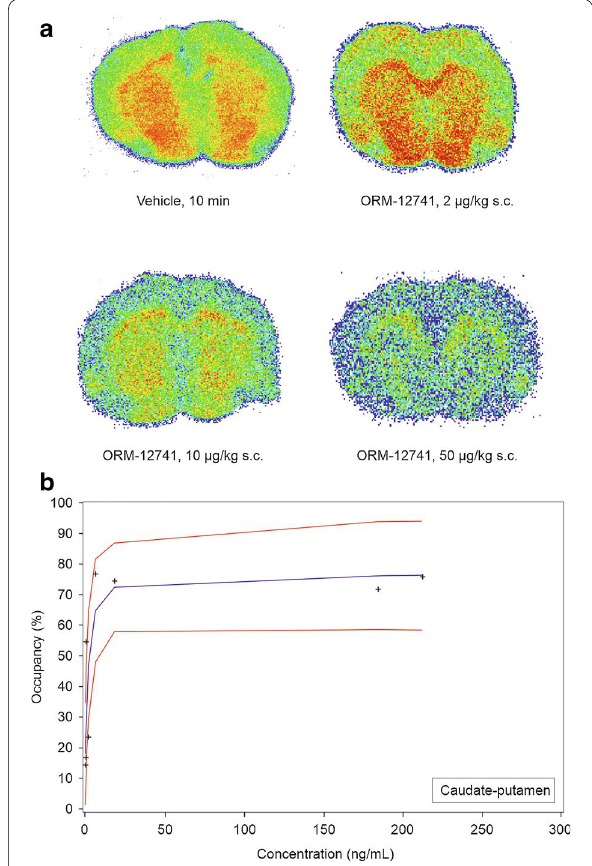
Fig. 1 a Representative 40 µm coronal brain sections from rats pre-treated with vehicle or ORM-12741 (2, 10, 50 µg/kg subcutaneously) at 10 min post [ 11 C]ORM-13070 intravenous injection. Sections are from the level of the caudate-putamen, olfactory tubercle and frontal cortex. The colour pseudo-autoradiograms show the regional distribution of the [ 11 C]-label, red highest, blue lowest uptake. b The relationship between ORM-12741 (10–1000 µg/kg s.c.) plasma levels and α 2C -adrenoceptor occupancy in rat striatum. The blue line represents a binding hyperbole derived from nonlinear regression analysis with a sigmoidal maximum possible effect model. The red lines represent 95% confidence